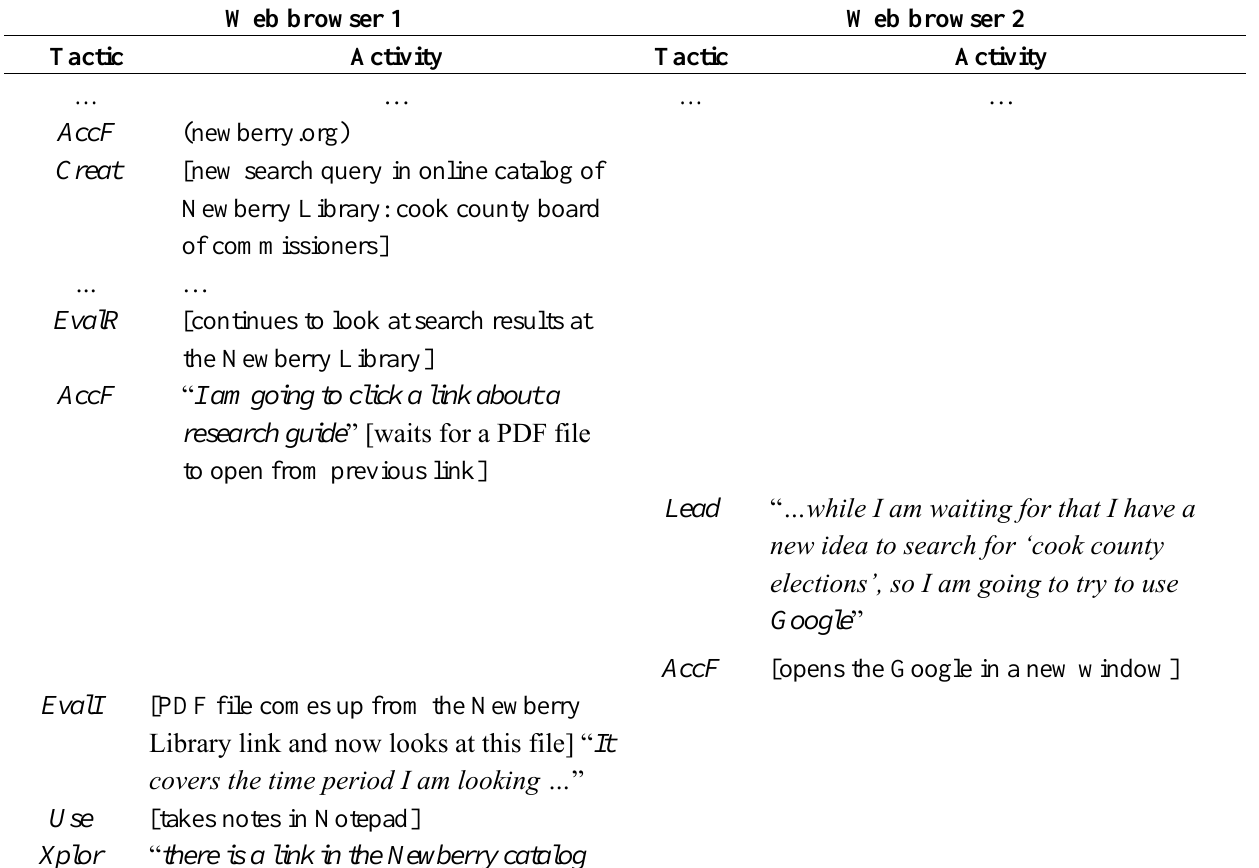
Table 9. Simultaneous multiple resource search